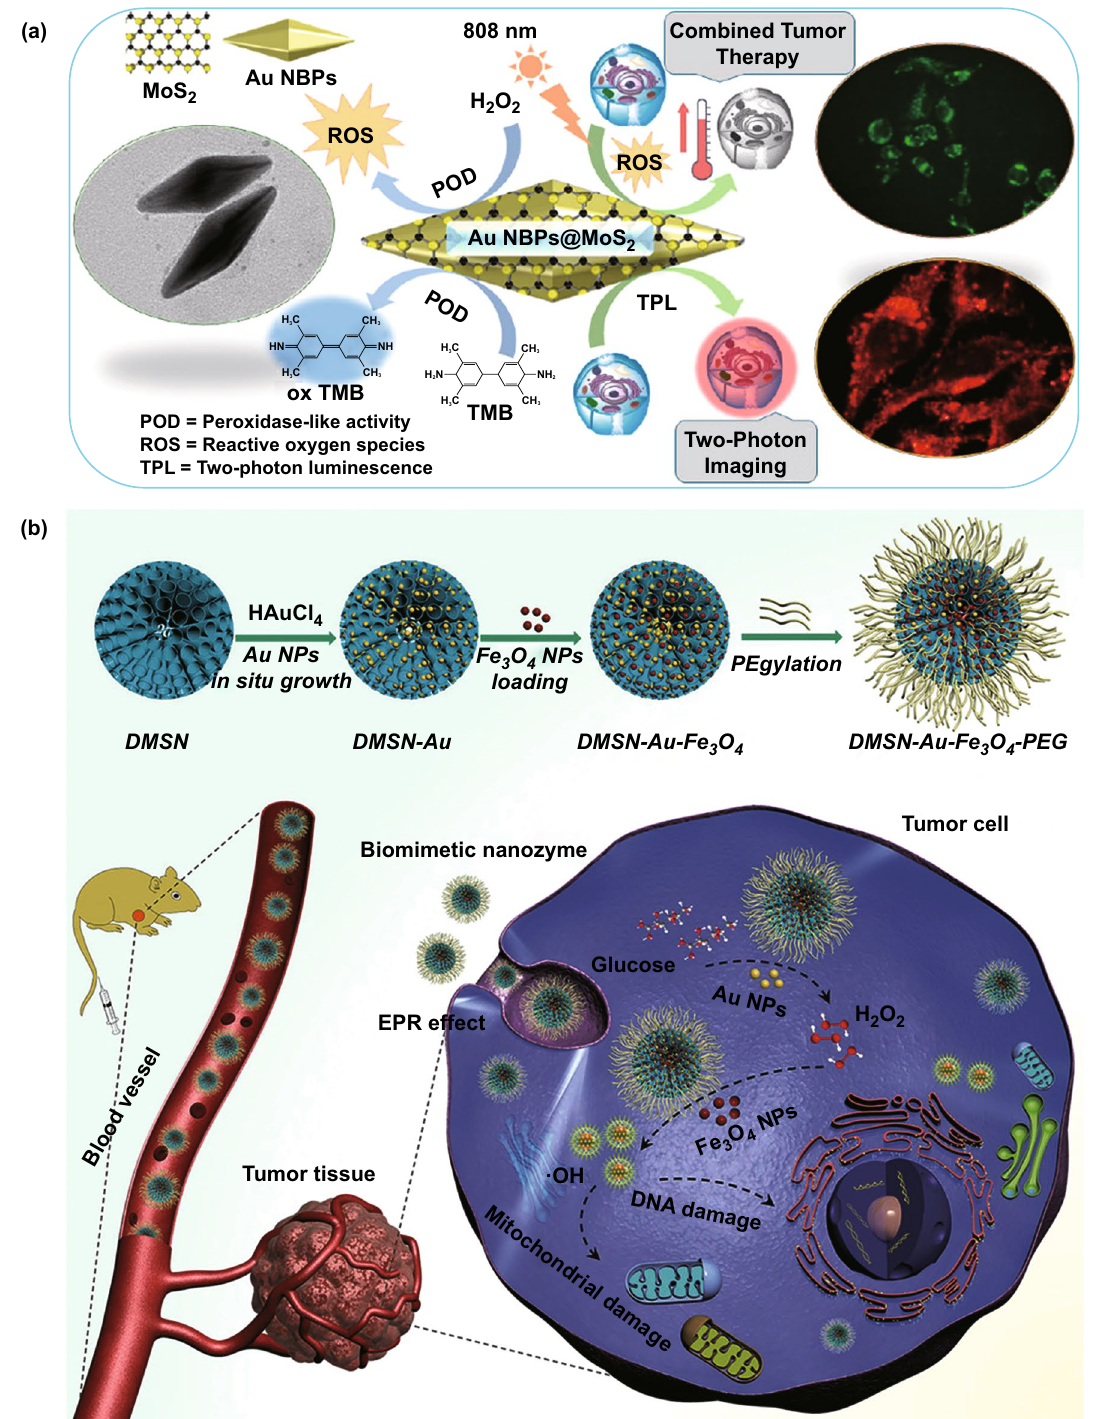
Fig. 8 Gold nanozymes applied for tumour therapy. a Peroxidase‑like activity is combined with photodynamic and photothermal therapies for tumour imaging and localized treatment [155]. Copyright 2018 American Chemical Society. b Various enzymatic activities are combined to generate ROS inside the cell after directing the NPs to the affected tissue [157]. Copyright 2018 Wiley–VCH Verlag GmbH & Co.